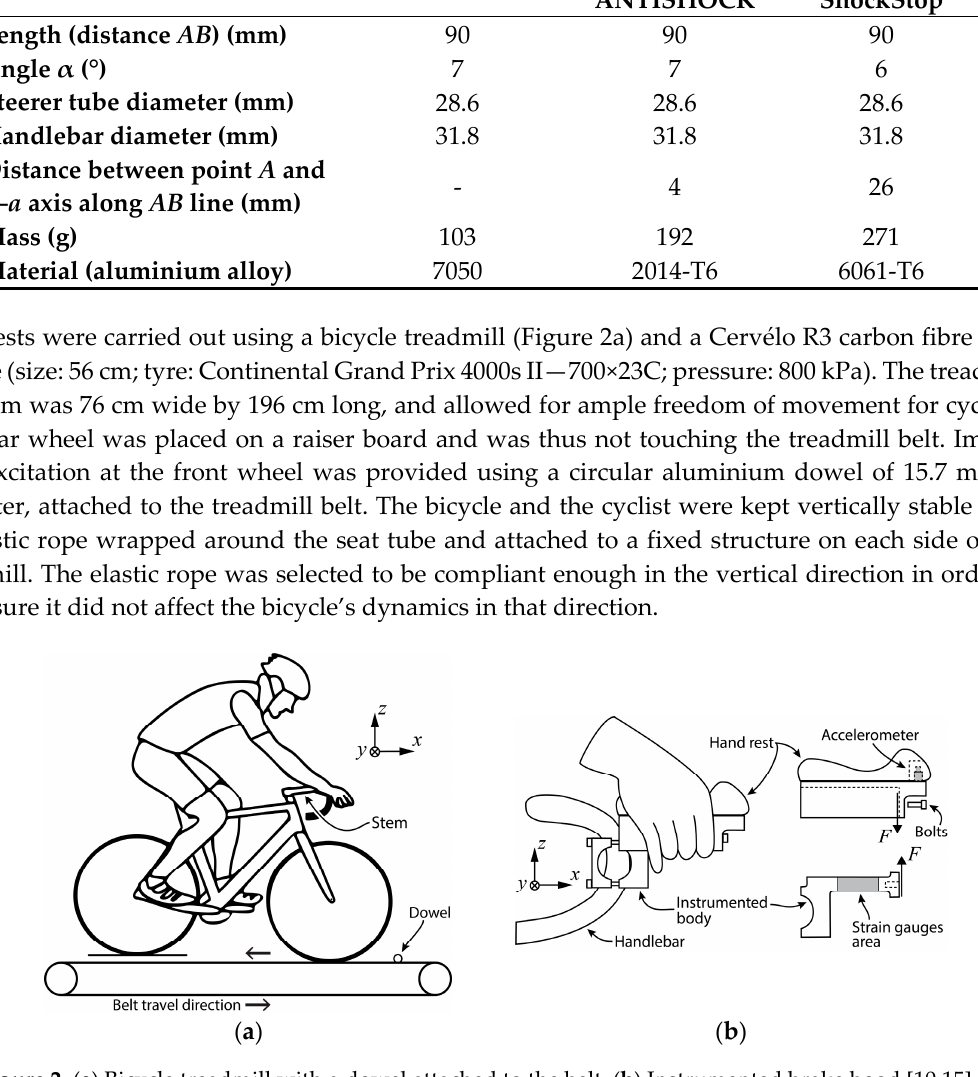
Figure 2. ( a ) Bicycle treadmill with a dowel attached to the belt. ( b ) Instrumented brake hood